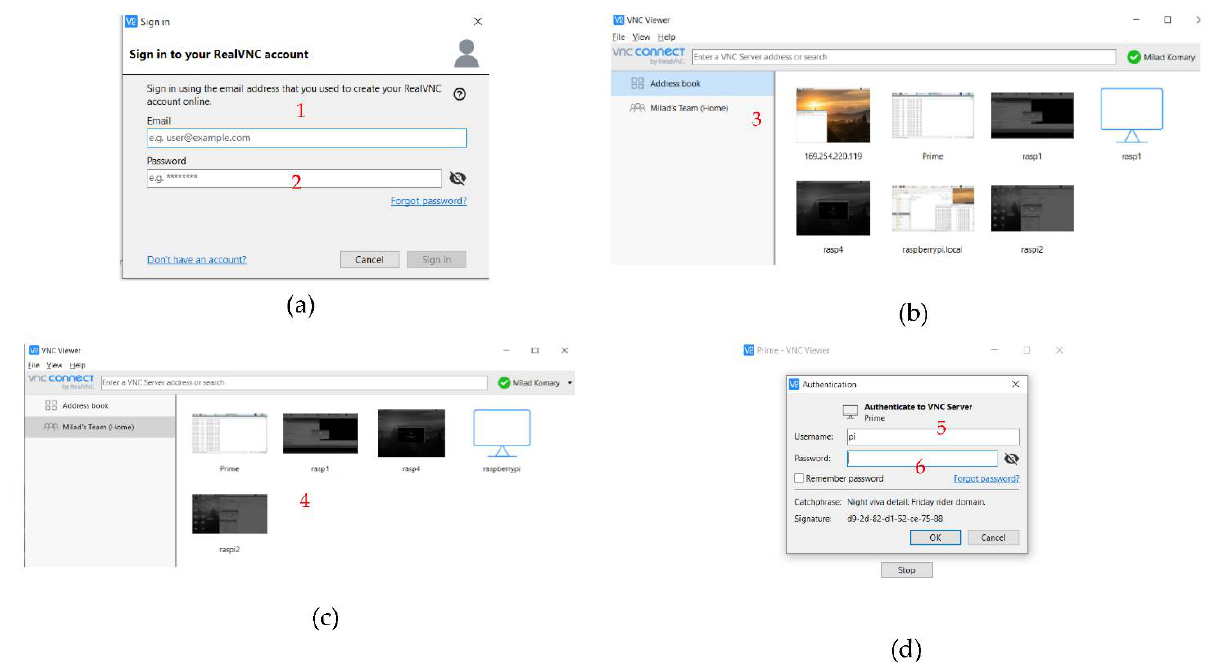
Figure 7. Entering the data acquisition system of a SARA: ( a ) Signing in to the VNC Viewer platform, ( b ) Main window of the VNC Viewer, ( c ) Choosing the accelerometer under study, ( d ) entering to the data acquisition platform of the selected accelerometer.